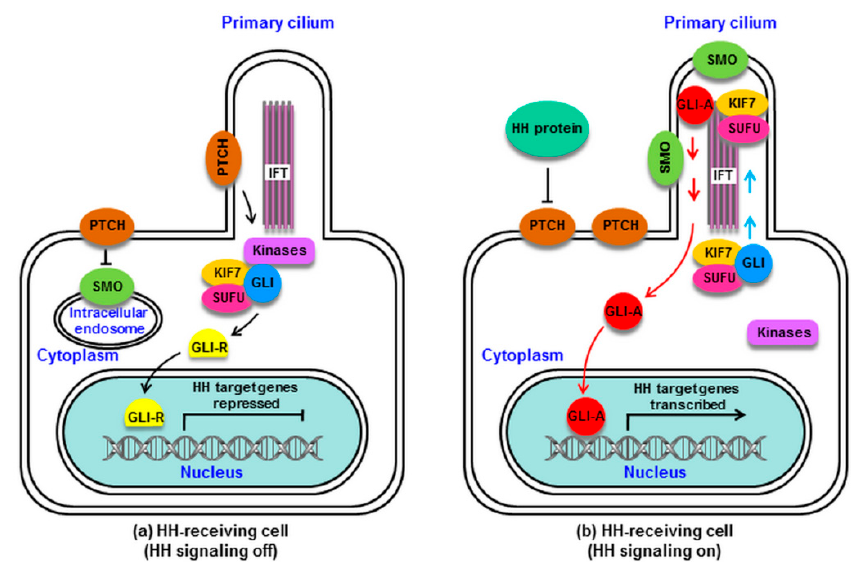
Figure 1. Mammalian hedgehog (HH) signaling. ( a ): Without HH proteins, patched (PTCH) is located at the cilium of the HH-receiving cell, and smoothened (SMO) remains distant from the cilium. PTCH inhibits SMO via preventing its cilial entry. Several kinases (PKA, CKI, GSK3) are recruited by the GLI / suppressor of fused (SUFU) / kinesin family protein 7 (KIF7) complex and activated by PTCH at the base of the cilium. GLI is phosphorylated by these kinases, which promotes its processing into the repressor GLI-R, which undergoes nuclear translocation to block HH target gene transcription. ( b ): HH protein binding to PTCH relieves SMO inhibition. PTCH is displaced from the cilium, and SMO accumulates in the cilium and converts from an inactive to active state. The GLI / SUFU / KIF7 complex is recruited by active SMO, traveling via intraflagellar transport (IFT) to the cilial top. SMO activation results in the detachment of GLI from SUFU and KIF7. GLI remains as an active GLI-A, which is translocated into the nucleus and goes on to induce HH target gene transcription. HH signaling is activated. CKI, casein kinase I; GLI, GLI protein (a zinc finger transcription factor); GLI-A, GLI activator; GLI-R, GLI repressor; GSK3, glycogen synthase kinase 3; IFT, intraflagellar transport protein; KIF7, kinesin family protein 7 (a minor inhibitor of GLI); PKA, protein kinase A; PTCH, Patched; SMO, Smoothened; SUFU, suppressor of fused (a major inhibitor of GLI).